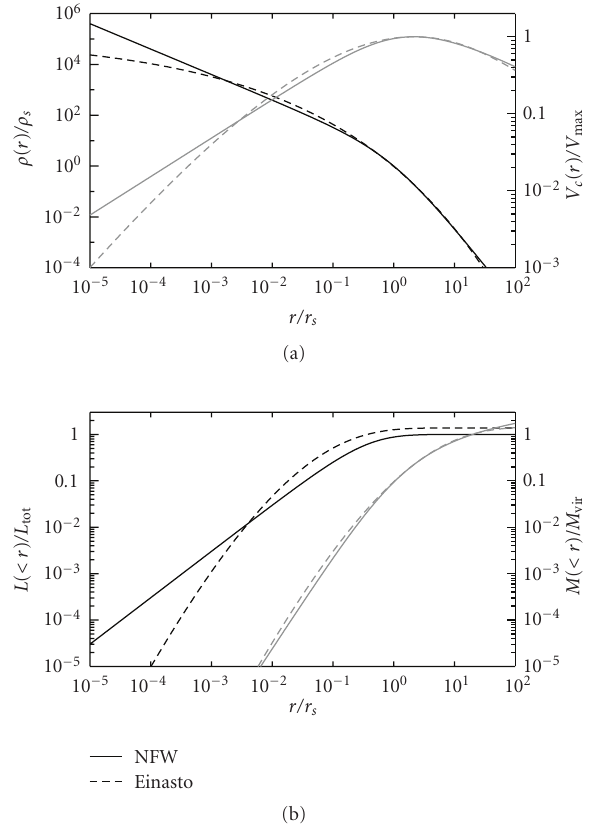
Figure 2: A comparison of NFW and Einasto ( α = 0 . 17) radial profiles of density (top, dark lines, left axis), circular velocity (top, light lines, right axis), enclosed annihilation luminosity (bottom, dark lines, left axis), enclosed mass (bottom, light lines, right axis). The density profiles have been normalized to have the same V max and r Vmax